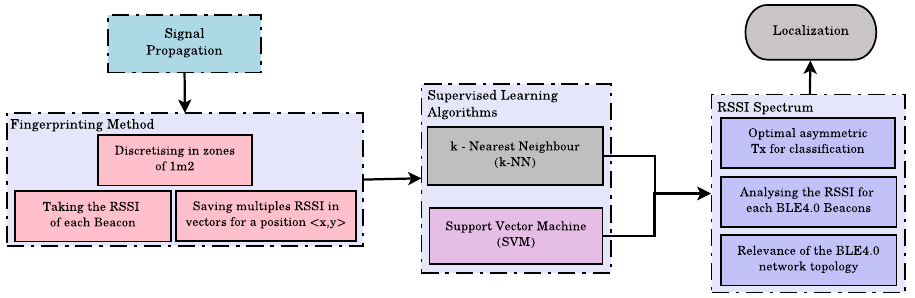
Figure 1. Overall schema